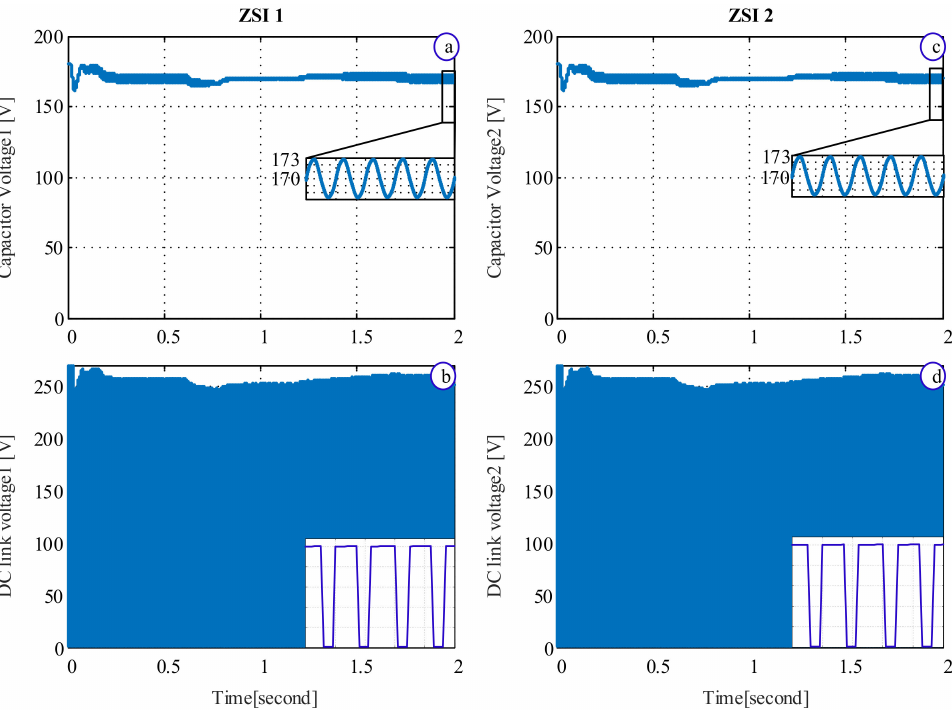
Figure 14. ( a ) Capacitor voltage of ZSI1, V c 11 , ( b ) DC link voltage of the ZSI1, V c 21 , ( c ) capacitor voltage of ZSI1, u in 1 , ( d ) DC link voltage of ZSI2, u in 2 .